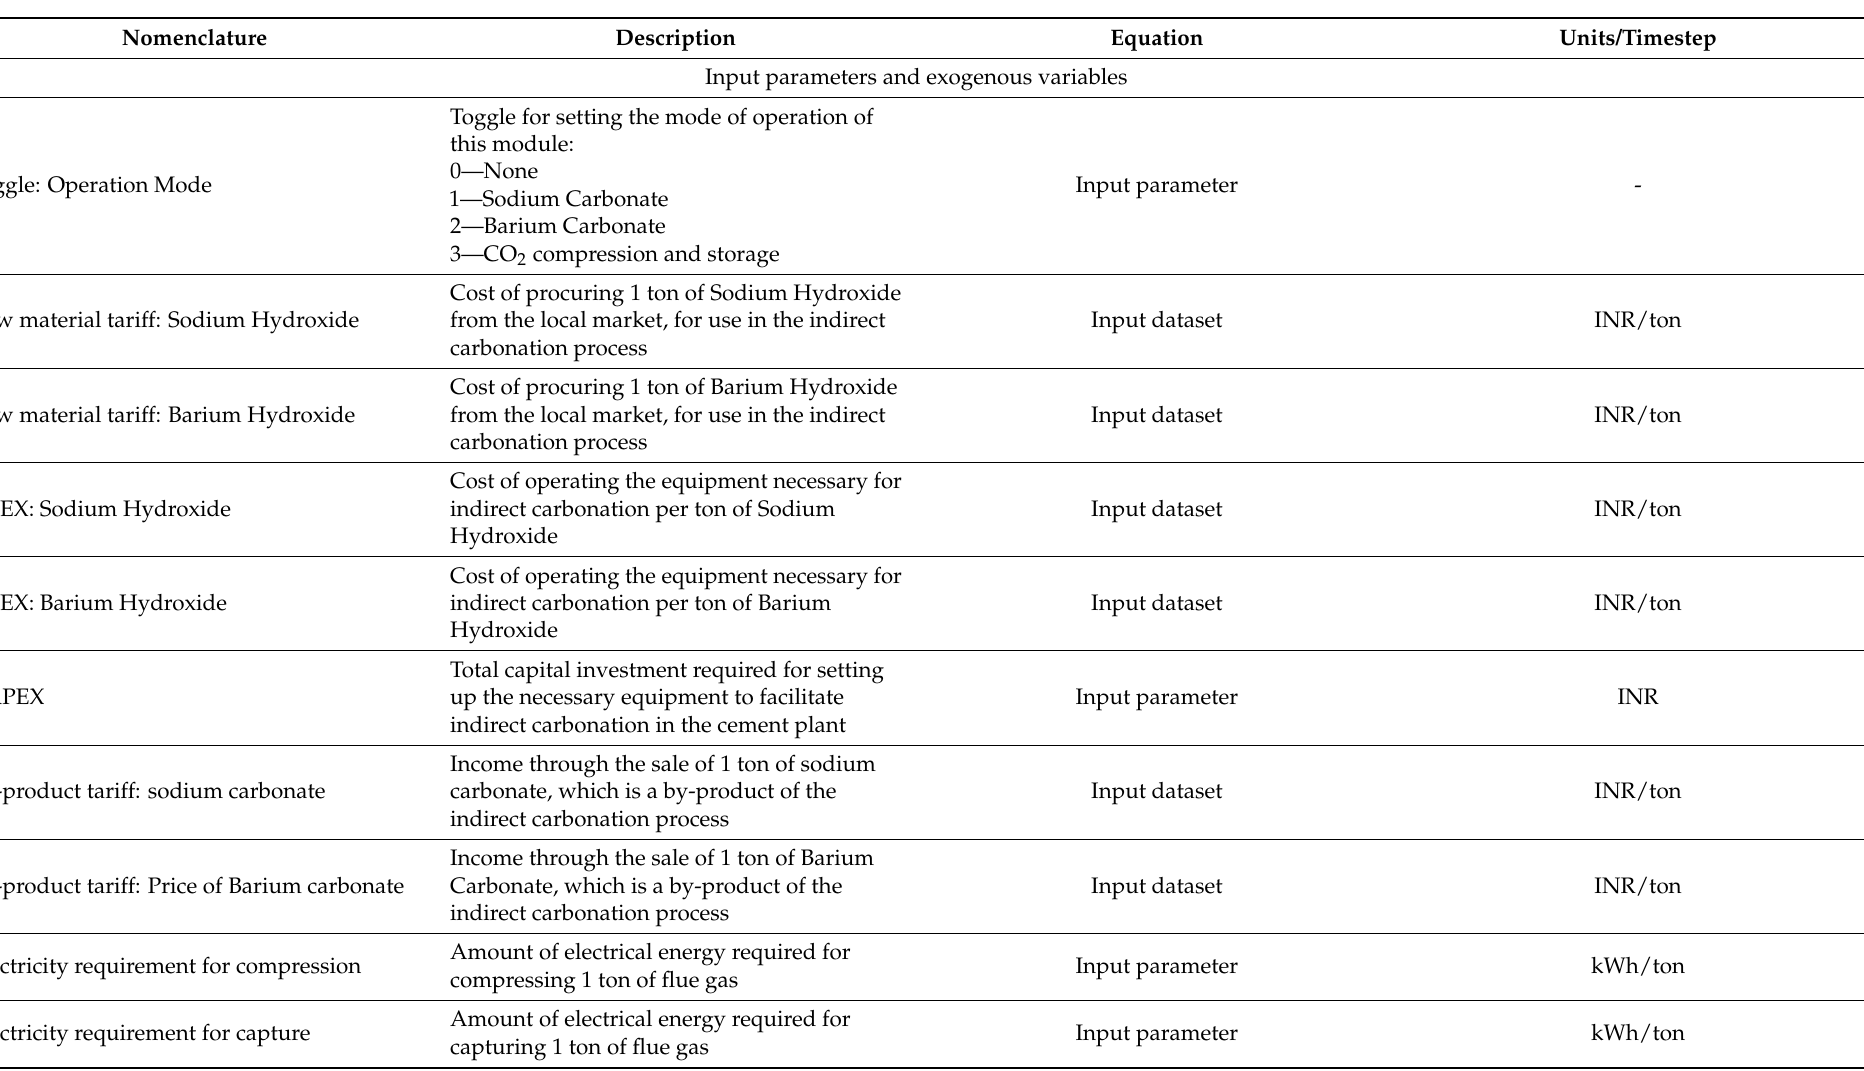
Table A4. Description of the variables used in the Carbon Capture